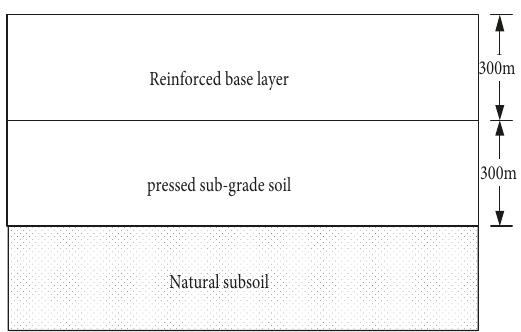
Figure 7: Onsite conditions of test section. Figure 8: Schematic illustration of test